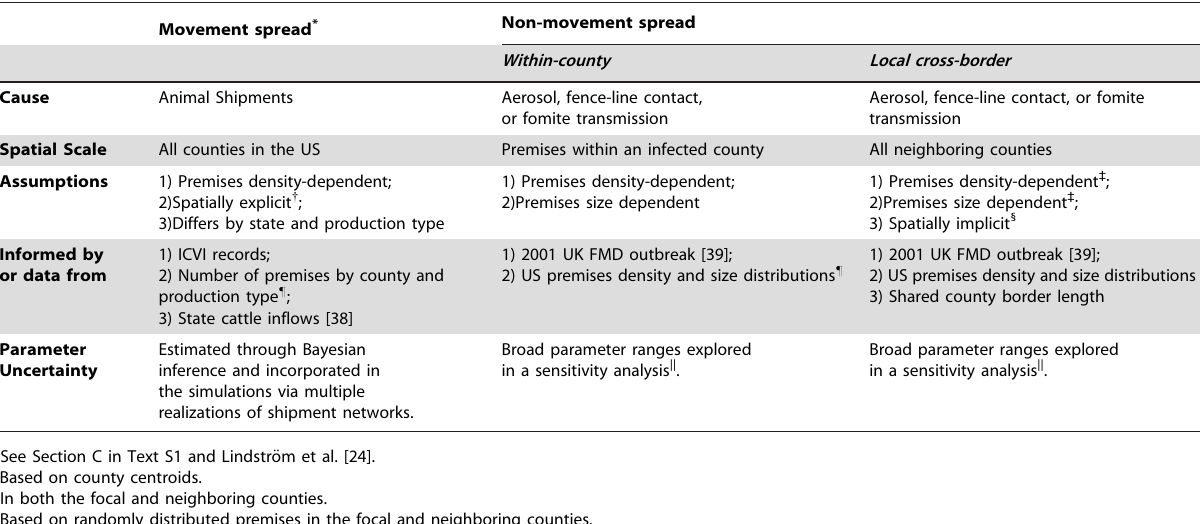
Table 1. Disease transmission routes in the